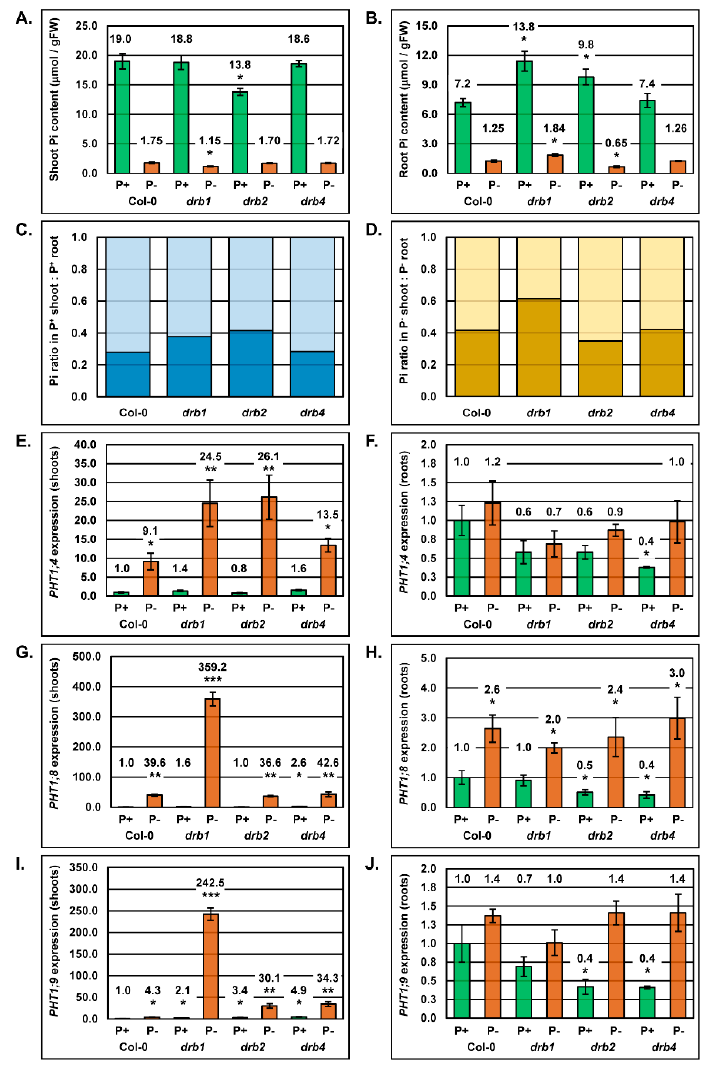
Figure 5. Pi content and PO 4 transporter gene expression in the shoot and root tissue of 15-day old Arabidopsis plant lines Col-0, drb1 , drb2 and drb4 cultivated under either a standard growth regime or post-exposure to a 7-day period of PO 4 starvation. ( A,B ) Comparison of the Pi content of the shoots (A) and roots (B) of 15-day old non-stressed and PO 4 -stressed Col-0, drb1 , drb2 and drb4 plants. ( C ) Pi content shoot (light blue) to root (dark blue) ratio of 15-day old Col-0, drb1 , drb2 and drb4 plants cultivated under standard growth conditions. ( D ) Pi content shoot (light gold) to root (dark gold) ratio of 15-day old Col-0, drb1 , drb2 and drb4 plants post 7-days of PO 4 starvation. ( E,F ) Quantification of PHT1;4 expression in the shoot (E) and root (F) tissues of 15-day old Col-0, drb1 , drb2 and drb4 plants cultivated under standard growth conditions or post a 7-day period of PO 4 starvation. ( G,H ) RT-qPCR assessment of PHT1;8 transcript abundance in the shoots (G) and roots (H) of 15-day old Col-0, drb1 , drb2 and drb4 plants cultivated under either standard or PO 4 stress conditions. ( I,J ) PHT1;9 expression in the shoot (I) and root (J) material of non-stressed or PO 4 -stressed Col-0, drb1 , drb2 and drb4 plants at 15 days of age. (A,B,E–J) Error bars represent the standard deviation of four biological replicates and